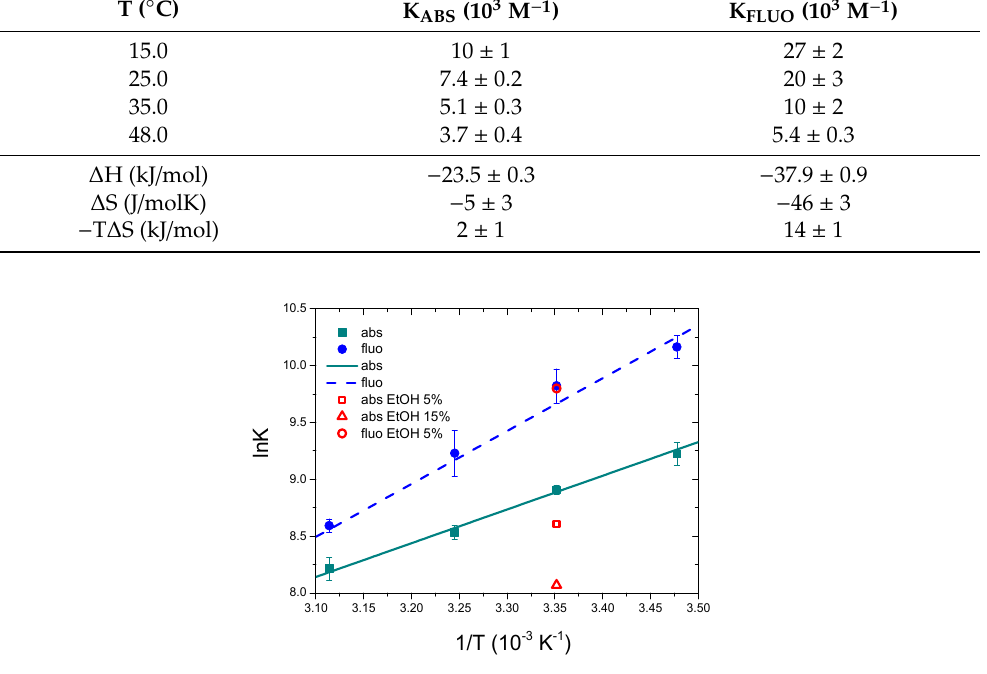
Figure 3. Spectrophotometric and spectrofluorimetric Van’t Hoff plots for the [Ag(EIA) 2 ] +